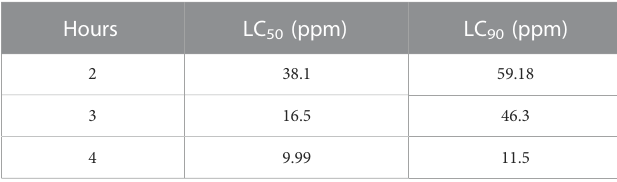
TABLE 3 Lethal concentration of the Neomitranthes obscura nanoemulsion in cercariae after 4 h.